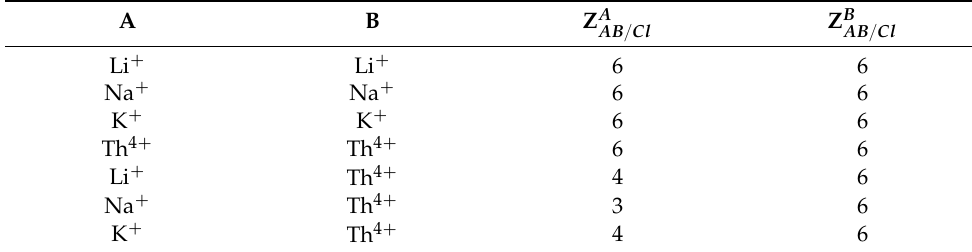
Table 3. Cation-cation coordination numbers of the liquid